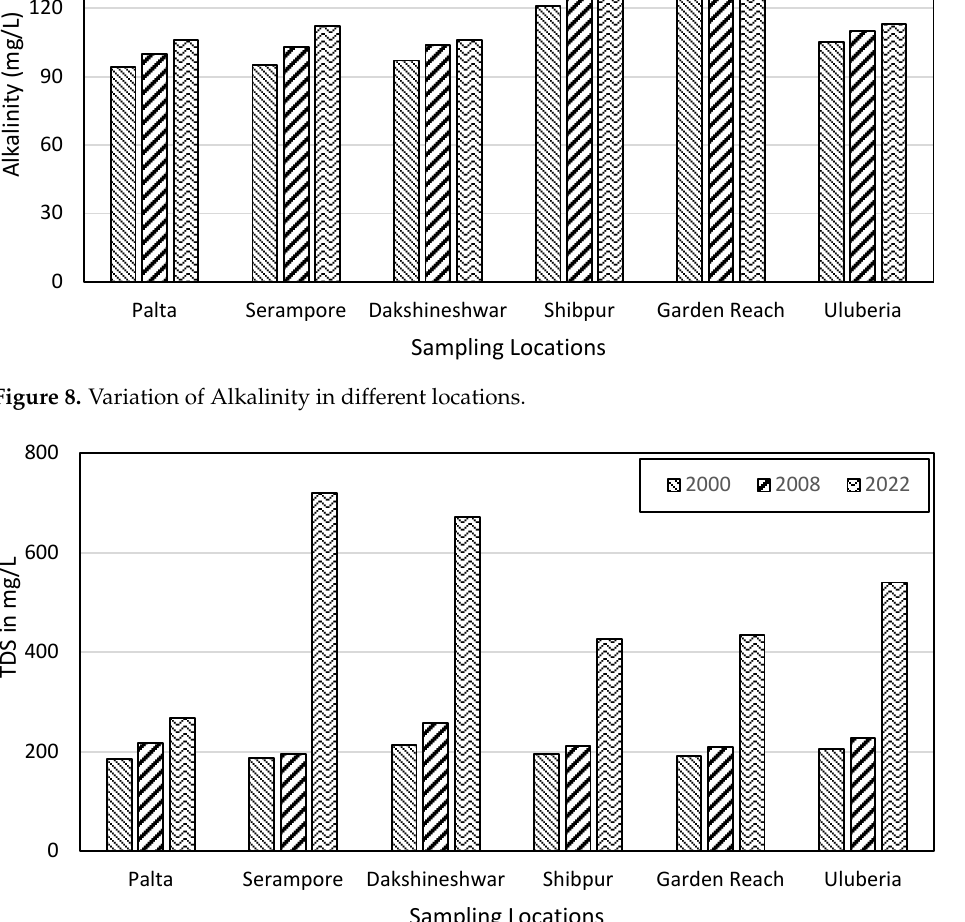
Figure 10. Variation of Dissolve Oxygen in different locations. Figure 11. Variation of BOD in different locations.